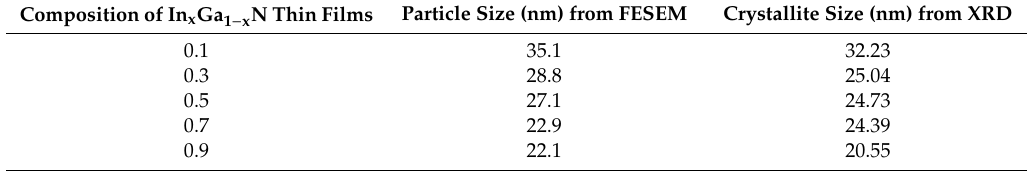
Table 3. The particle size measurements from FESEM and Scherer’s equation for thin films deposited on a glass